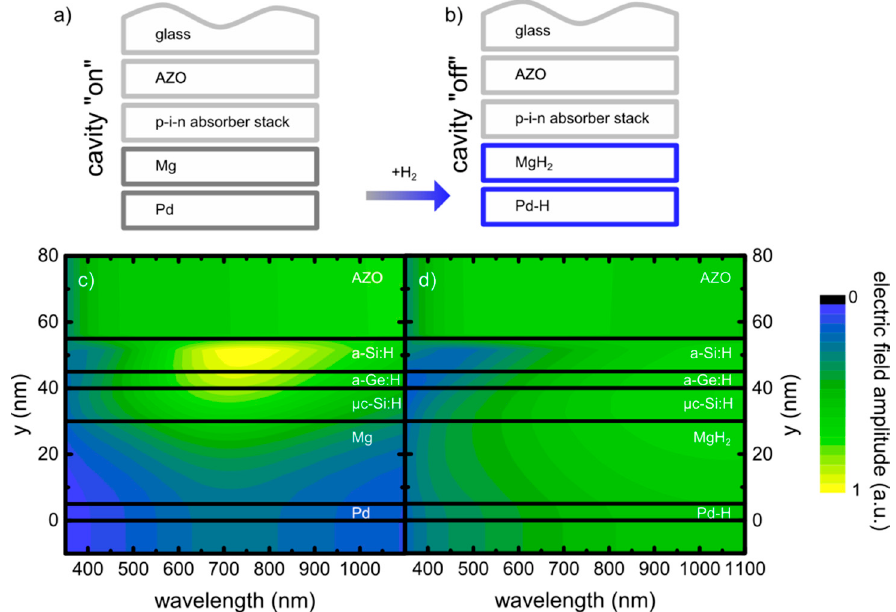
Figure 6. Switchable solar cell using Mg and Pd rear contact ( a ). Upon Hydrogen absorption, the mirror layers change to MgH 2 /PdH ( b ). The simulated electric field amplitude inside the device in a cavity “on” ( c ) and a cavity “off” state ( d ).